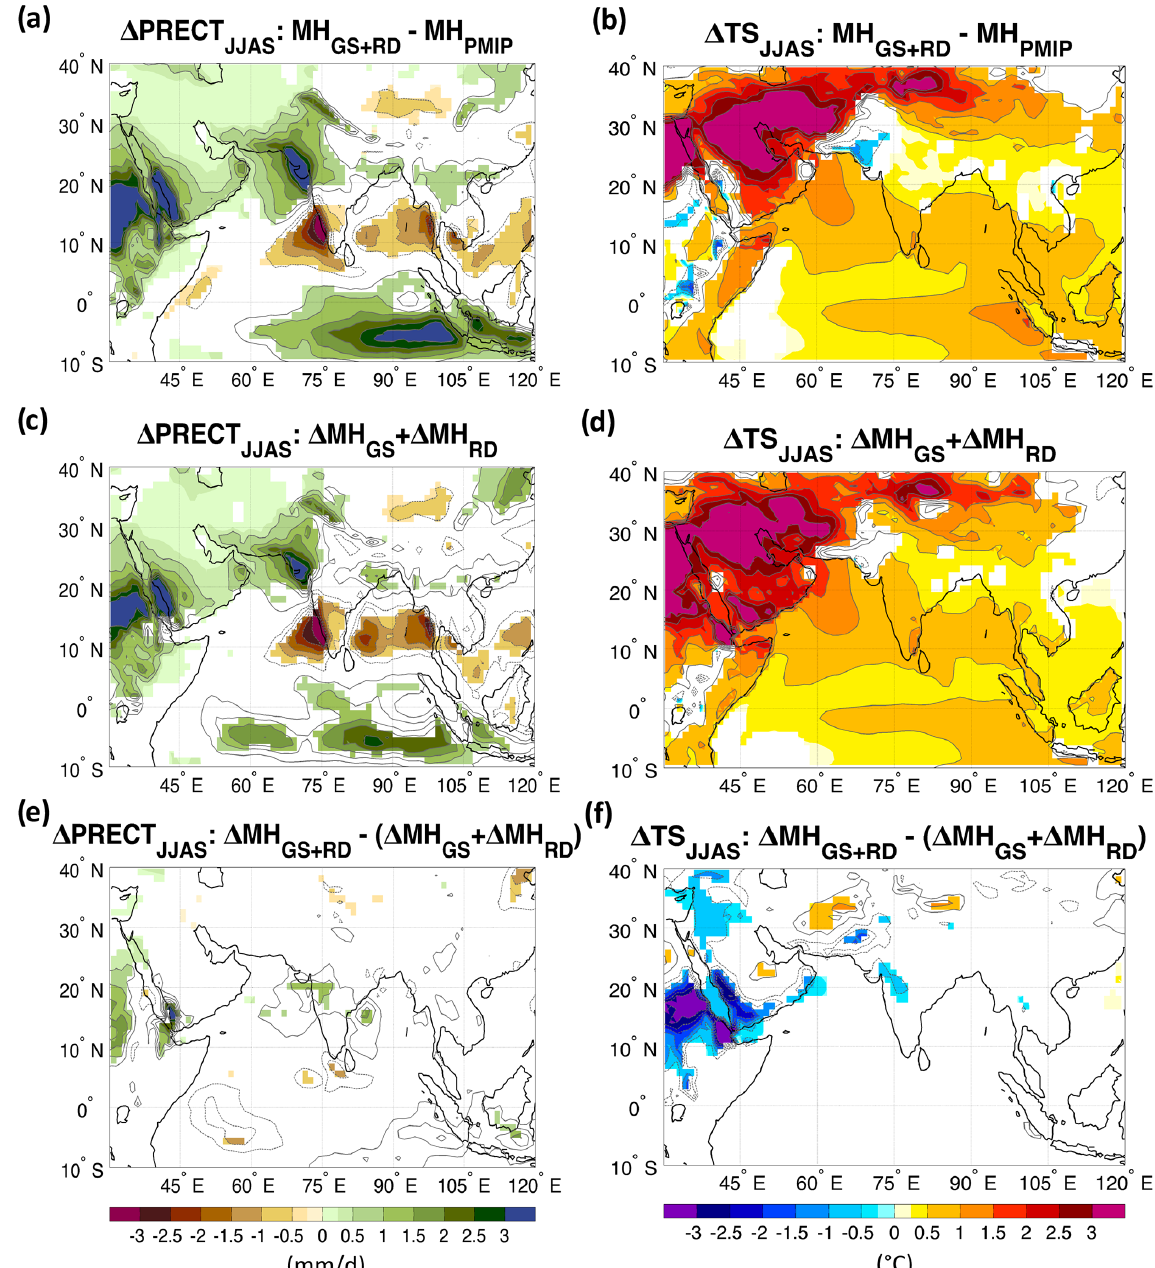
Figure A4. (a) Summer (JJAS) precipitation (PRECT, mm/d) and (b) surface temperature (TS; ◦ C) anomalies between the MH GS + RD and the MH PMIP experiments. (c) The sum of MH GS and MH RD precipitation and (d) surface temperature anomalies relative to the reference MH PMIP experiment. (e) – (f) Difference between panels (a) and (c) , and (b) and (d) , respectively. Only differences significant at the 95% confidence level using the Student t test are